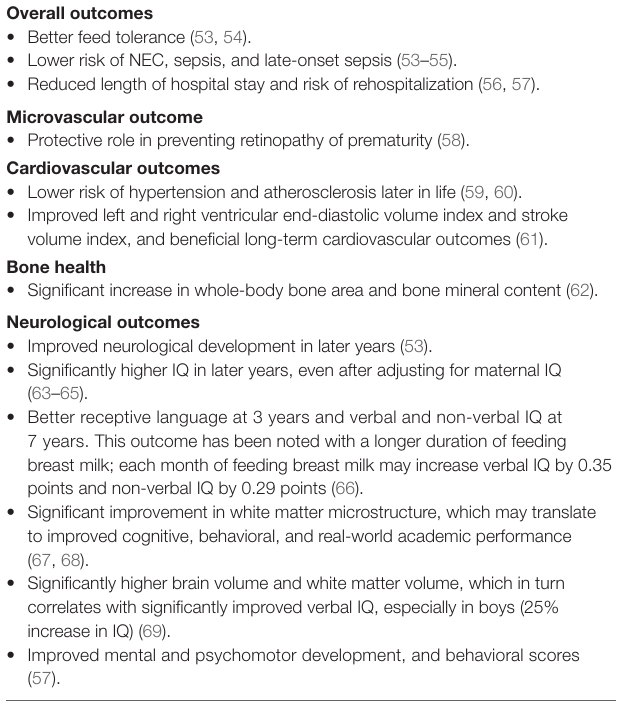
TaBLe 2 | advantages of feeding breast